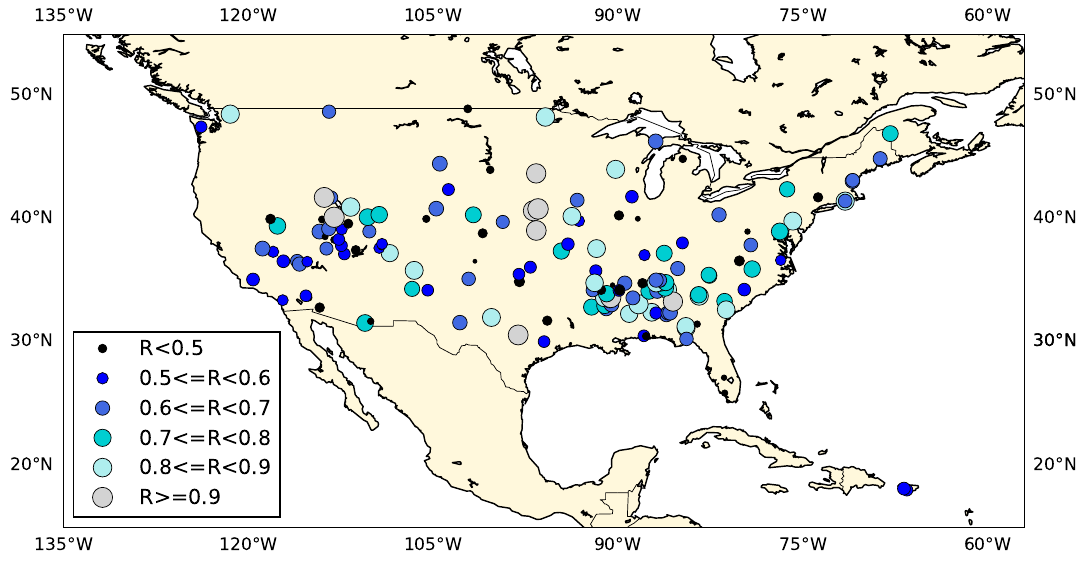
Figure 6. Correlation coefficient (R) of the SMOS experiment soil moisture analysis with in situ observations. The size of the circles is proportional to